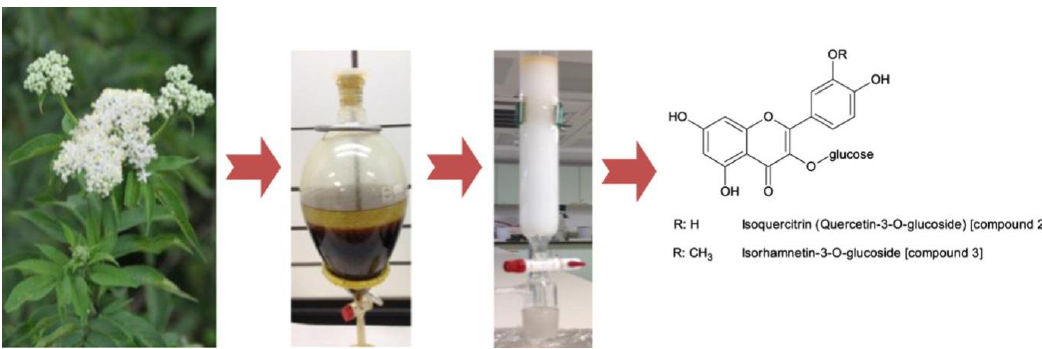
Figure 5 . Extracting Effective Compounds from Sambucus nigra (Yesilada et al.,